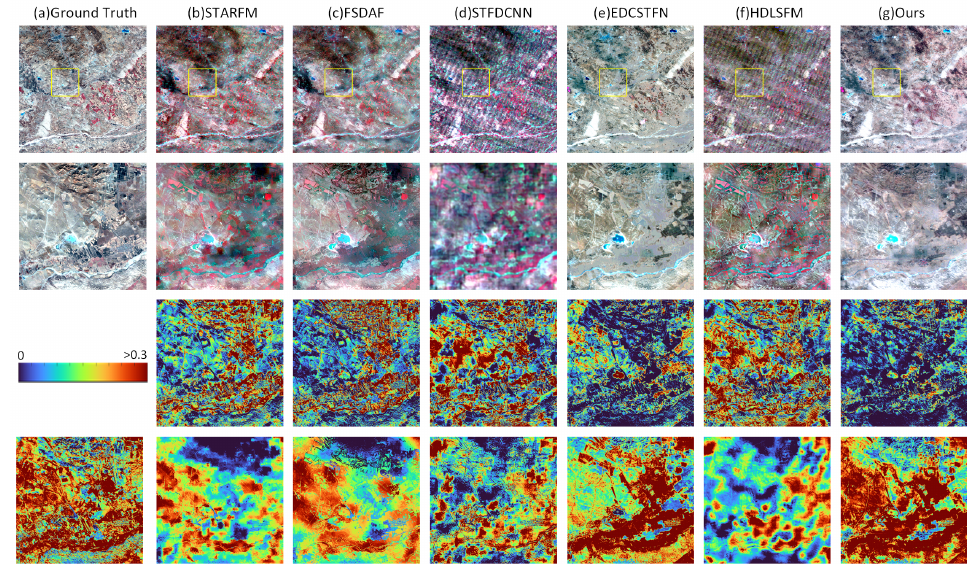
Figure 13. The fusion results on 4 January 2018 in AHB (the arrangement of the subfigures is the same as the above). Table 2. Evaluation metrics of AHB prediction results. Bold values indicate the best